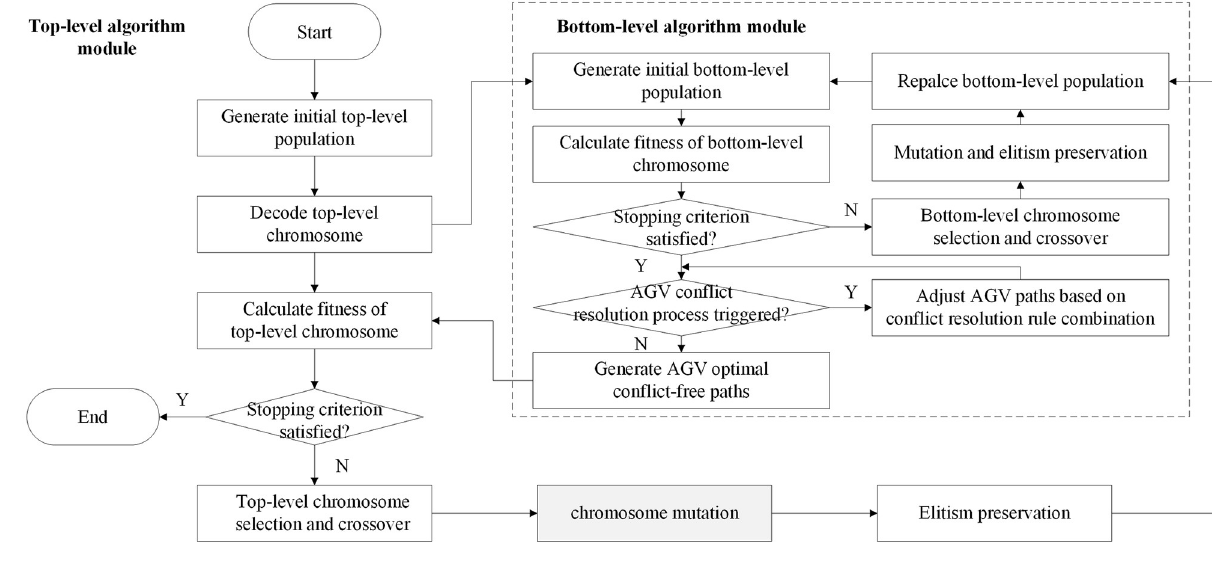
Fig 9. Flow chart of the